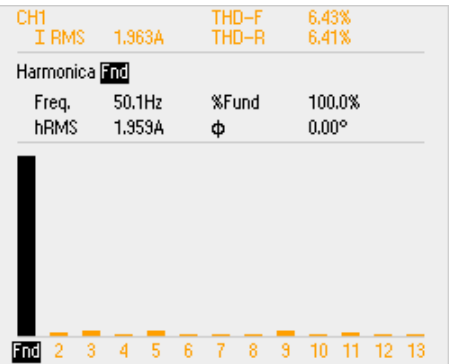
Figure 38. Harmonic spectrum of the grid current in V2G mode.